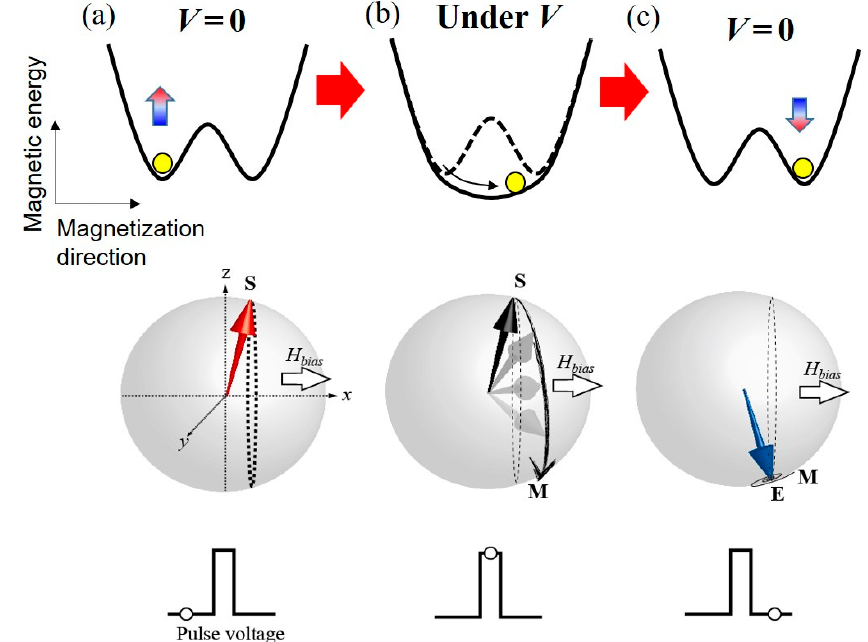
Figure 4. Conceptual diagram of voltage-induced dynamic switching for a perpendicularly-magnetized film. The in-plane bias magnetic field, H bias , which determines the axis of the precessional dynamics, is applied in the + x direction. ( a ) initial state (point S), ( b ) precessional switching process induced by an application of pulse voltage (from point S to point M), and ( c ) relaxation process (from point M to point E).